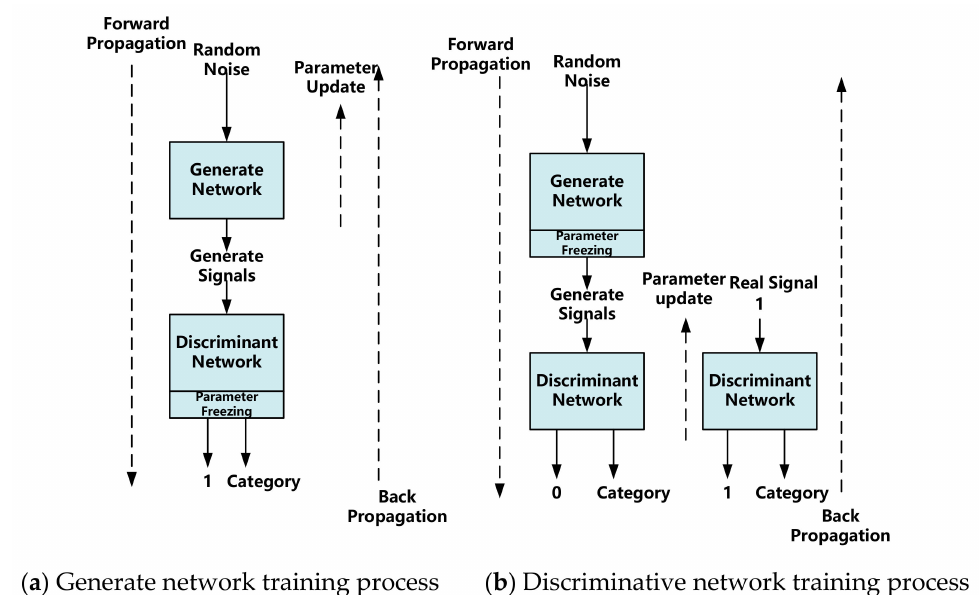
Figure 8. Schematic diagram of the GAN training